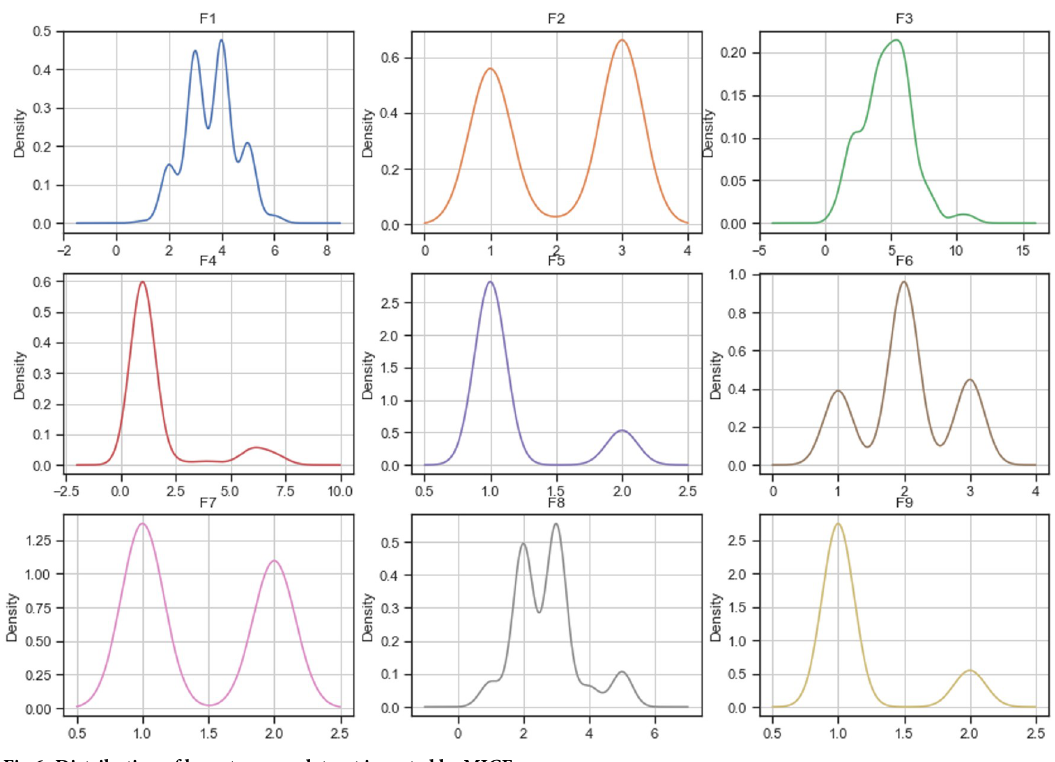
Fig 6. Distribution of breast-cancer dataset imputed by